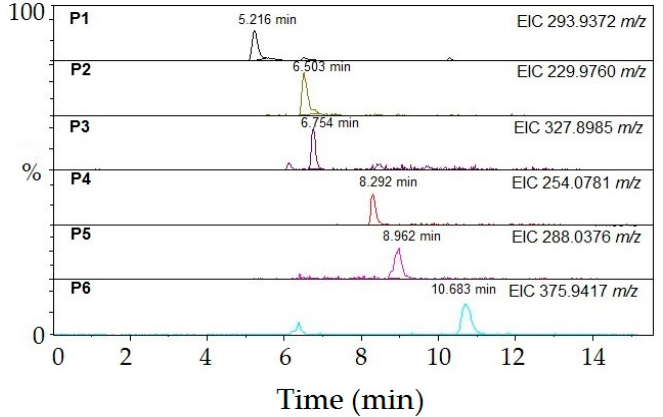
Figure 2. Liquid chromatography ‐ time of flight/mass spectrometry (LC ‐ TOF/MS) chromatograms of all HDZ by ‐ products.